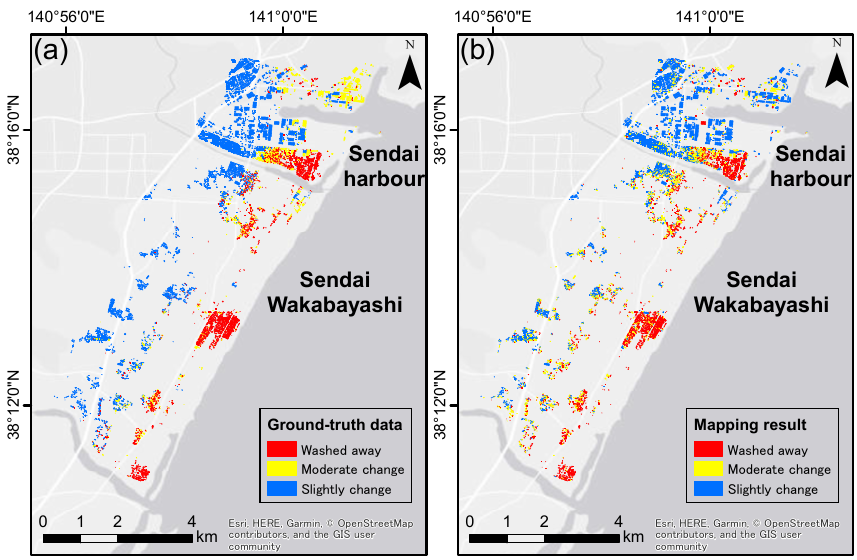
Figure 7. Mapping result of Scheme 2: ( a ) ground truth data; and ( b ) mapping